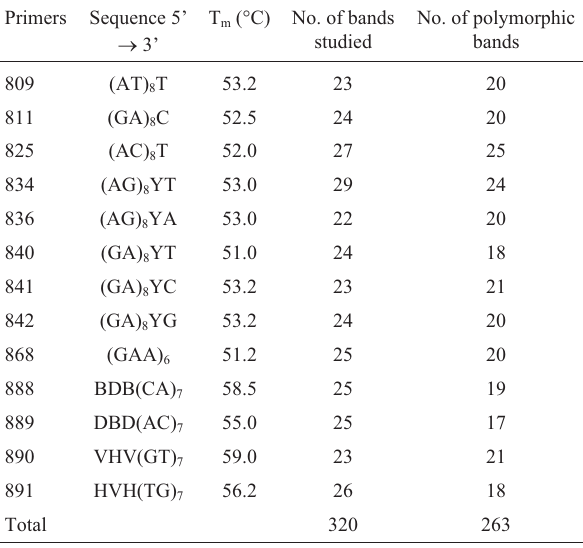
Table 2 - Primers used for ISSR amplification and bands amplified in all individuals sampled. Primers Sequence 5’ (cid:6)